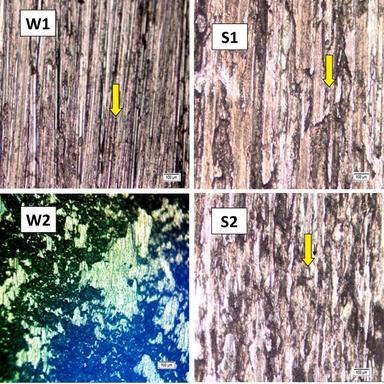
Optical micrographs for worn surface of the W1, W2, S1 and S2 investigated alloys, Mag 10X